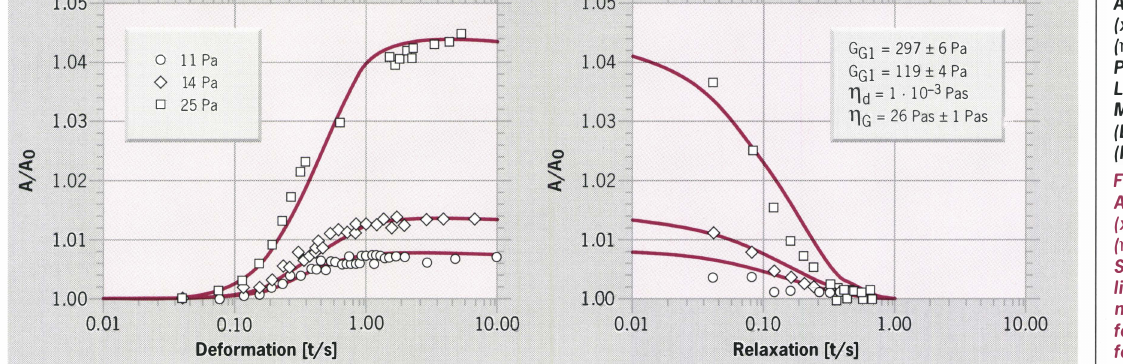
Fig. 6: A/A0{t} of water droplets {x � 500 >tml in silicone oil {Tlk = 10.5 Pas}. Symbols: experimental data; line: calculated based on the model using equation {14} for constant strain and I 16 I for